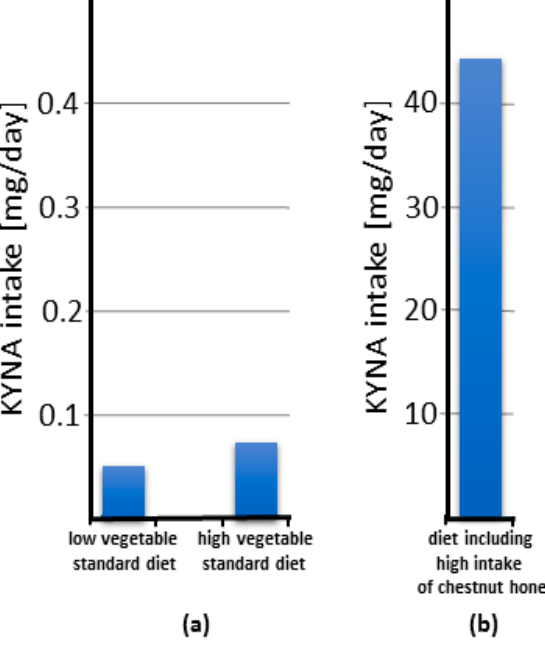
Figure 5. Estimation of the daily intake of kynurenic acid (KYNA) in standard diets and diets rich in chestnut honey. The columns reflect the value of the highest reported content of KYNA (see Table S4 for detail). Note that the scale on panel ( b ) is 100 times larger than on panel ( a ). The daily intake of KYNA in the diet was calculated as follows. The calculation of food-related KYNA intake was based on simulation of a dish of cruciferous, yellow, green and other vegetables mixed equally assuming that a single serving weighs 80 g according to Bensley et al. 2003 [124]. The KYNA ingested in red meat, poultry, eggs and other extensively analyzed nutrients is omitted due to trace of their contents. Low intake was established as consumption of three or fewer servings per week. High intake was established as consumption of more than 10 servings per week.